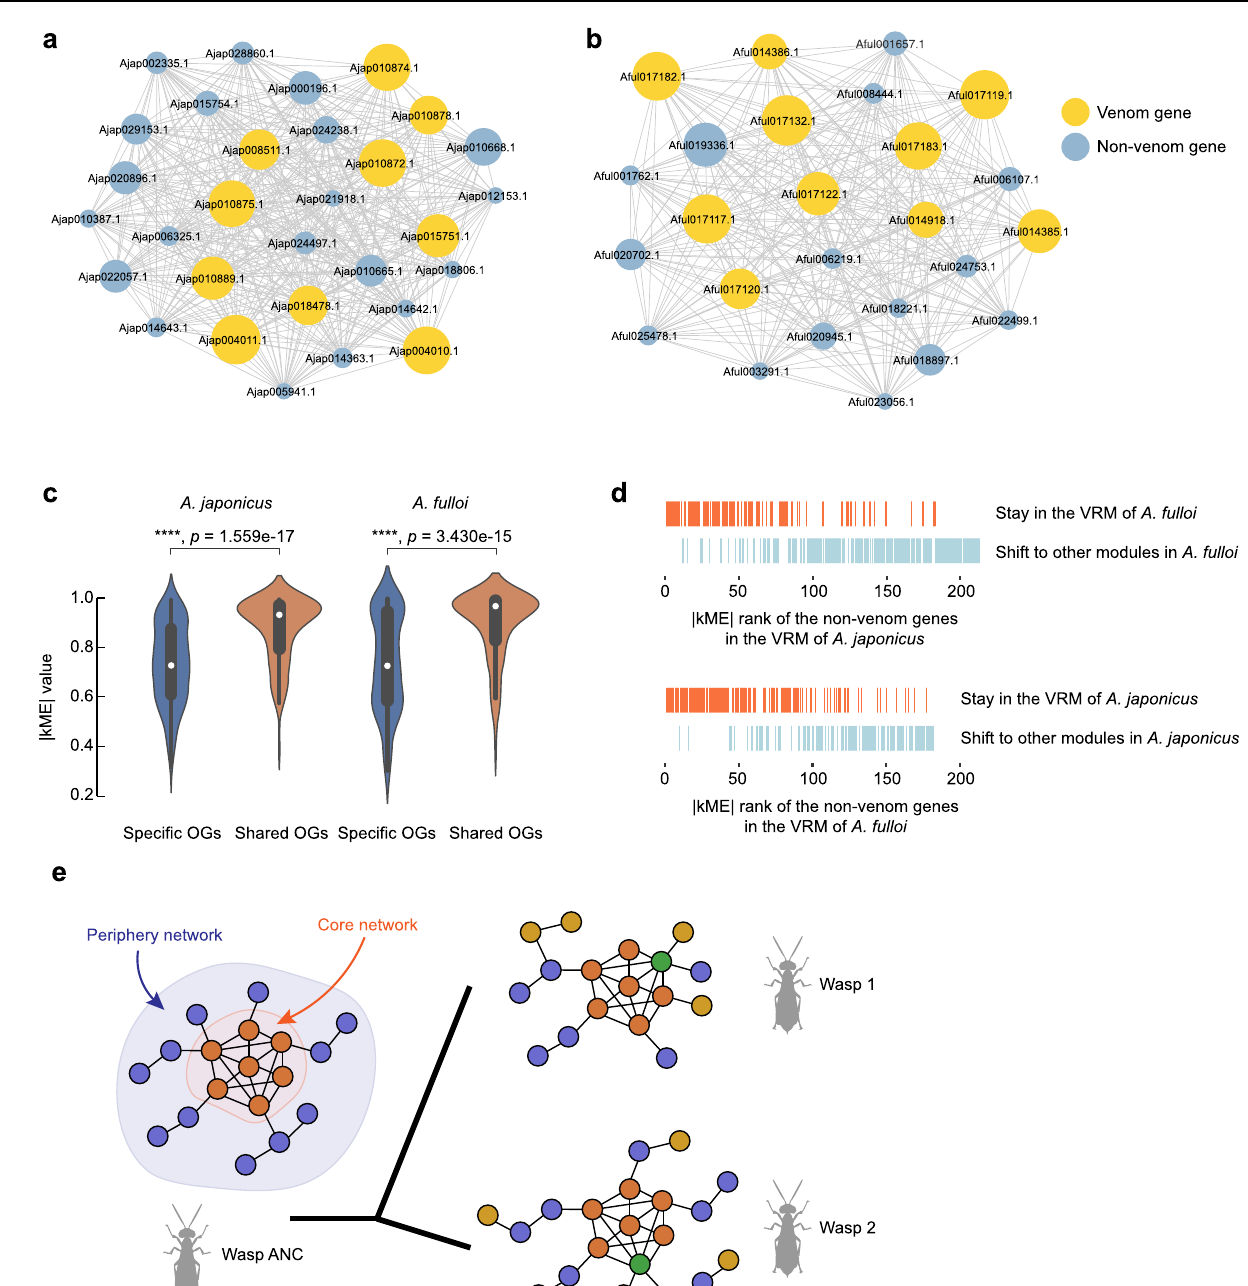
Fig. 6 | The venom-related network module evolution in Anastatus wasps. The venom-related network modules (VRMs) of A. japonicus ( a ) and A. fulloi ( b ), com- priseatotalof632and560genes,respectively.Sincebothnetworkshaveover500 genes, visualizingtheentirenetworktopologywouldbeimpractical. Here, we only selected the top 20 highly expressed non-venom genes (in blue), and the top 10 highlyexpressedvenomgenes(inyellow)forvisualization.Thetopicsizeindicates the expression level (log 2 TPM). c The non-venom genes in VRM from the shared OGs between the two Anastatus wasps have signi fi cantly higher network con- nectivity than the non-venom genes from the speci fi c OGs ( p <0.0001, two-sided Wilcoxon rank-sum test). n Ajap_speci fi c_OGs =297; n Ajap_speci fi c_OGs =125; n Aful_speci®- c_OGs=241; n Aful_speci fi c_OGs =138.Boxplotsdisplayingtheinterquartilerange(IQR,the 25 th and 75 th percentiles) with median values (white dots), and whiskers extending tothehighestandlowestpointswithin1.5×theIQRareshownovereachviolinplot.